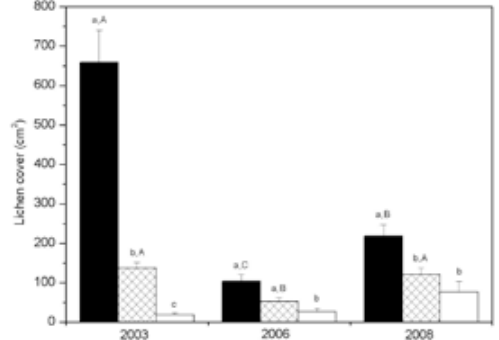
Fig. 3. Mean lichen cover area (cm 2 ) in patch (black; n =19), scatter (cross-hatched; n =20) and control (white; n =9) plots over time. Dif- ferent lower case letters indicate significant between-treatment differences (Tukey’s test: P <0.05); different capital letters indicate significant between-year differences (Paired t -test: P <0.05). Error bars=Standard error of mean (SEM).